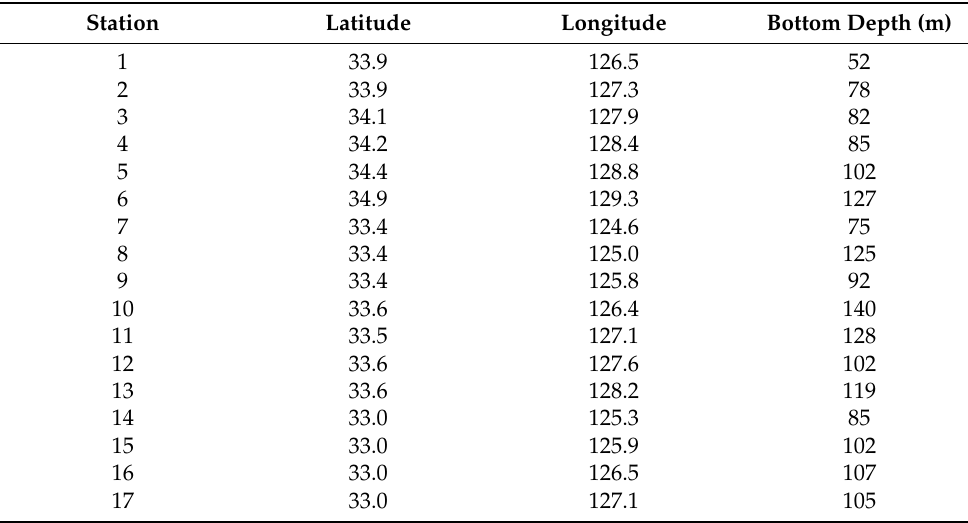
Table 1. Geographic coordinates of the study sites in the Korea South